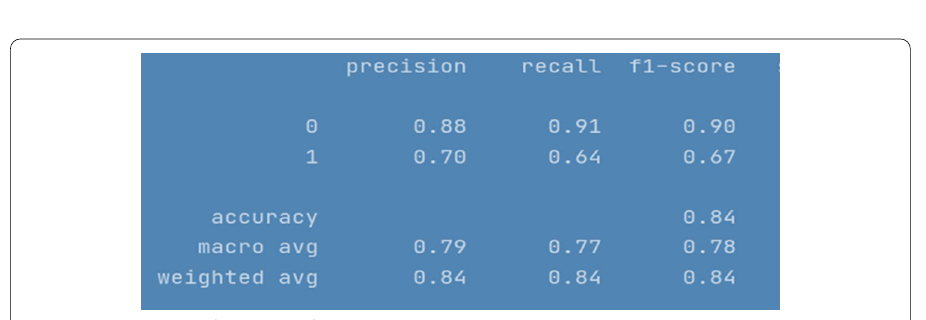
Fig. 9 RNN-BiLSTM evaluation